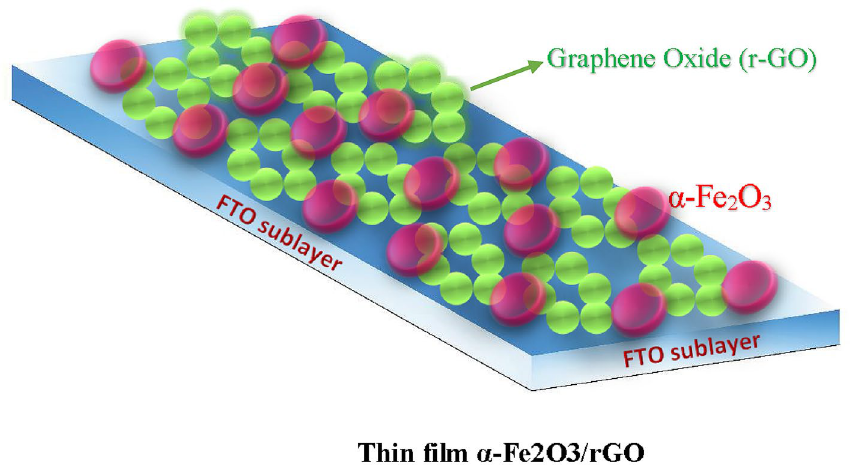
Figure 1. Synthesis of thin-film α-Fe2O3/rGO on the FTO